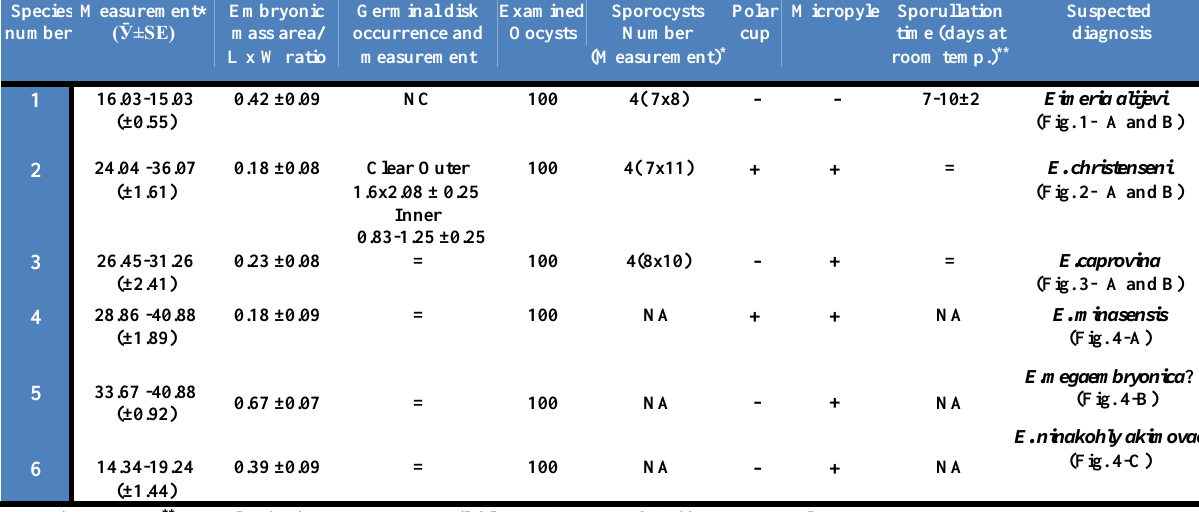
Table, 2: Characteristics features of Eimeria spp. isolated from local meriz ( Capra ibex ) goats.